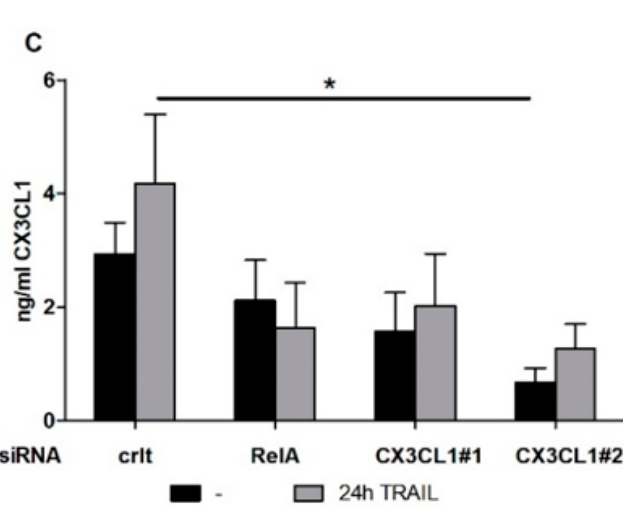
Figure 2. TRAIL upregulates CX3CL1 expression in resistant PDAC in a RelA dependent fashion ( A ) Panc1 and MiaPaca2 cells or ( B ) siRNA transfected Panc1 were treated TRAIL (10 ng/mL) for indicated times or left untreated and CX3CL1 mRNA expression was analyzed by realtime PCR. For control, β -actin qPCR was conducted; ( C ) Media were chanced to 0.5% FCS containing media 48 h after transfection and cells were treated with 10 ng/mL TRAIL for left untreated. After 24 h supernatants of Panc1 cells were collected and the concentration of CX3CL1 in the media was determined by ELISA. Data represent mean values ± SD from four independent experiments performed in duplicates. * p -values < 0.05.